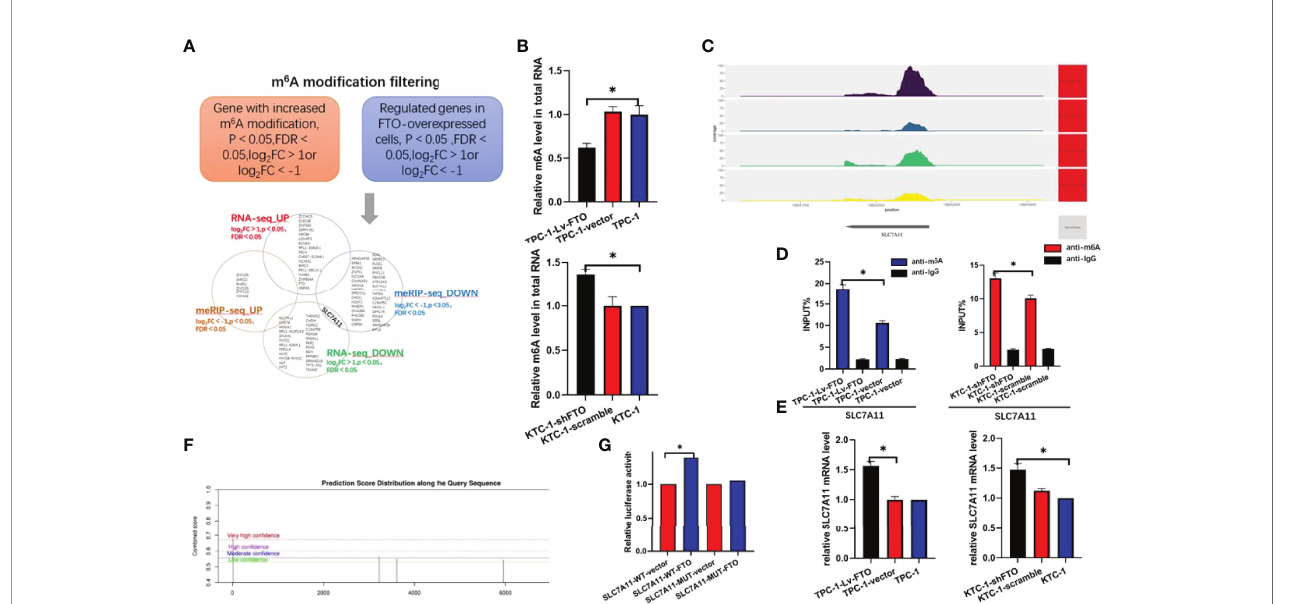
FIGURE 5 | RNA-seq and meRIP-Seq combined with RNA-Seq reveals SLC7A11 as a target of Fat mass and obesity-associated protein (FTO). (A) Screening SLC7A11 as the downstream target of FTO by bioinformatics analysis. m6A site of SLC7A11 in genetic coverage. (B) EpiQuik ™ m6A RNA Methylation Quanti fi cation Kit was used to identify whether m6A modi fi cation was enriched in the TMBIM6 sequence. (C) m6A peak in SLC7A11 by meRIP-Seq sequencing. (D) MeRIP assays were performed to identify variations in m6A modi fi cation enrichment in SLC7A11 after silencing or overexpressing FTO in lung squamous cell carcinoma cells. (E) qRT-PCR analysis of SLC7A11 mRNA after FTO inhibition or overexpression. (F, G) The luciferase report experiment con fi rmed that the overexpression of FTO eliminated the m6A modi fi cation of SLC7A11 mRNA in TPC-1 cells. *, P<0.05.